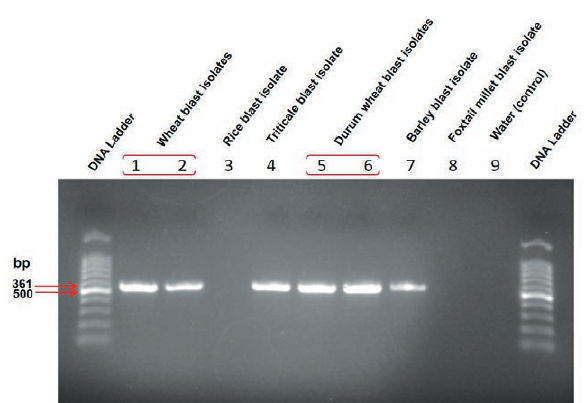
Figure 4. PCR amplification of durum wheat blast isolates DuBWMRI1901.2A (lane 5) and DuBWMRI1902.76C (lane 6), and blast isolates from wheat (lanes 1 and 2), rice (lane 3), triticale (lane 4), barley (lanes 7), and foxtail millet (lane 8), using MoT3 primer sets for confirming the Triticum pathotype of the Magnaporthe ory- zae pathogen, during molecular detection assay.